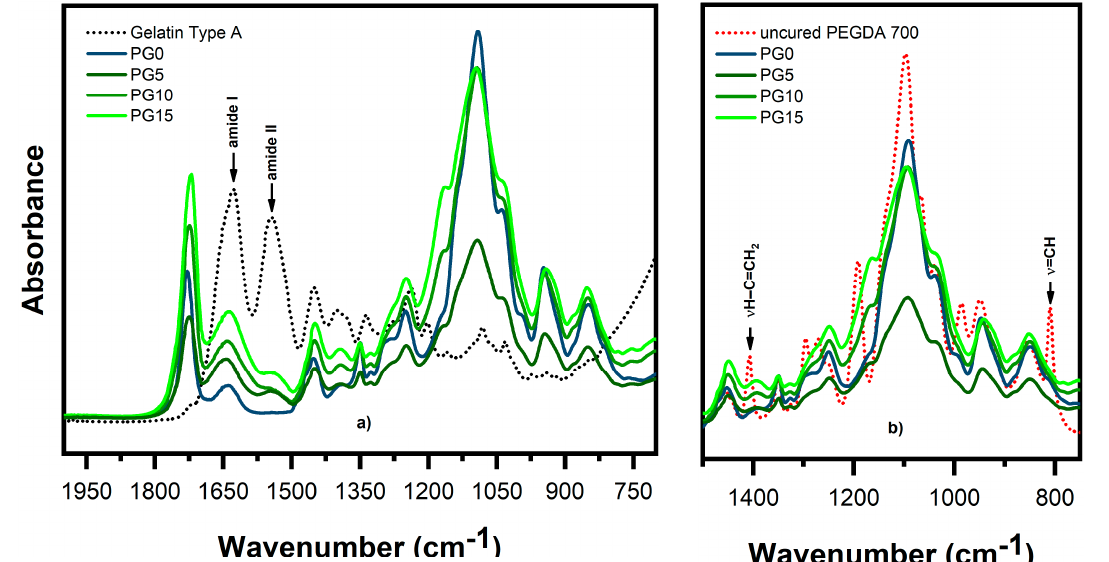
Figure 3. Attenuated total reflectance-infrared spectroscopy (ATR-FTIR) spectra of ( a ) the hydrogel samples and physically cross-linked gelatin reported in the range of 2000–700 cm − 1 ; ( b ) a comparison between the spectra of the different cured samples and the spectrum of uncured poly(ethylene glycol) diacrylate (PEGDA) in the region 1950–1450 cm − 1 .